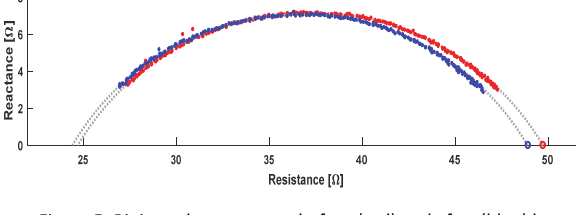
Figure 5. Bioimpedance spectra before (red) and after (blue) leg compression. Dashed circular arcs mark the extrapolated values according to the Cole model.